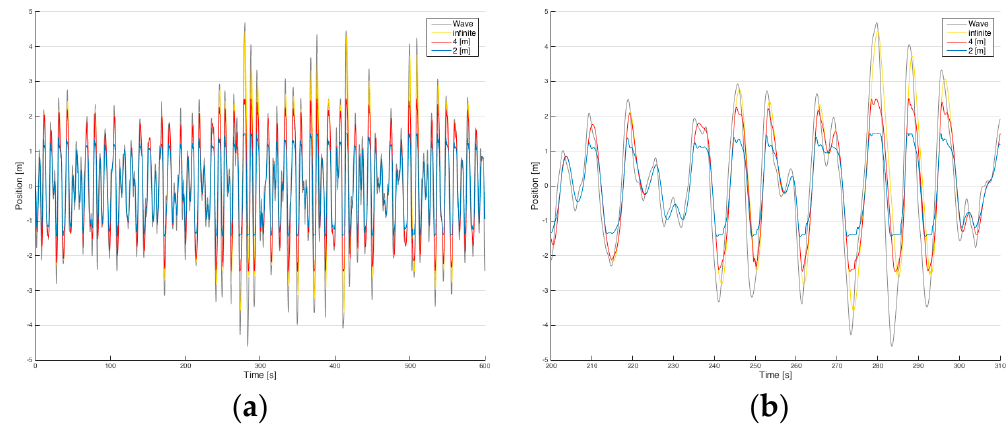
Figure 4. The translator’s position with three different stroke length settings (2 ‐ m, 4 ‐ m and infinite): ( a ) with a 10 min time span; and ( b ) with a 1.5 min time span. The wave climate for ( a ) and ( b ) is Hs = 6.25 m, Te = 9.5 s.